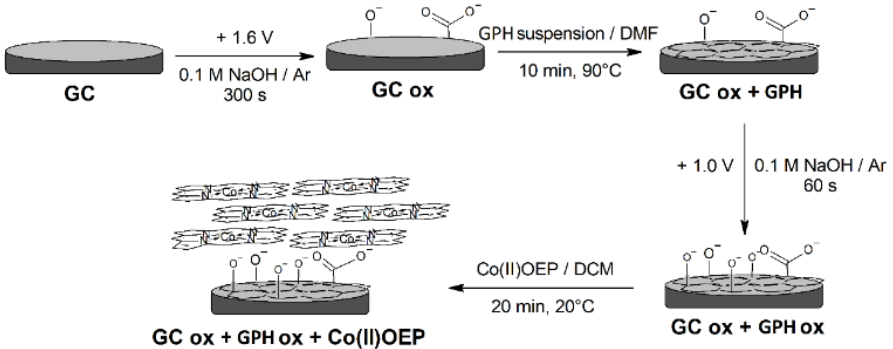
Figure 1. Modification diagram of vitreous carbon electrode (GC = Glassy Carbon, ox = oxidized, GPH = Graphene, Co(II)OEP = cobalt(II)octaethylporphine, DFM = dimethylformamide, DCM = dichloromethane).